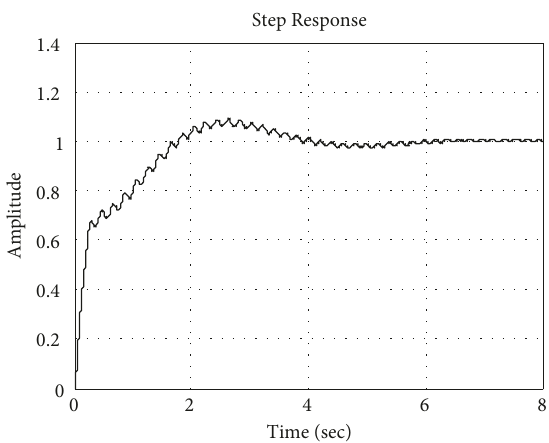
Figure 23: Response curve at 10 times β